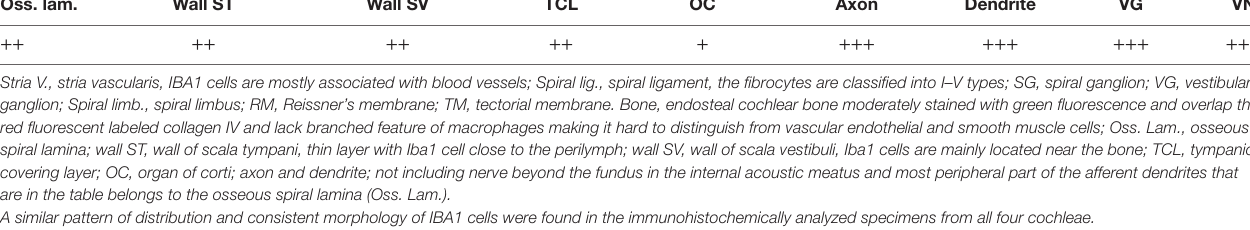
Table 3 | Distribution of ionized calcium-binding adaptor molecule 1 (IBA1)-IR cells in the human cochlea. stria V spiral lig. iii spiral lig. ii, iV, V sg spiral limb. TM/rM bone +++ ++ + +++ + − + Oss. lam. Tcl